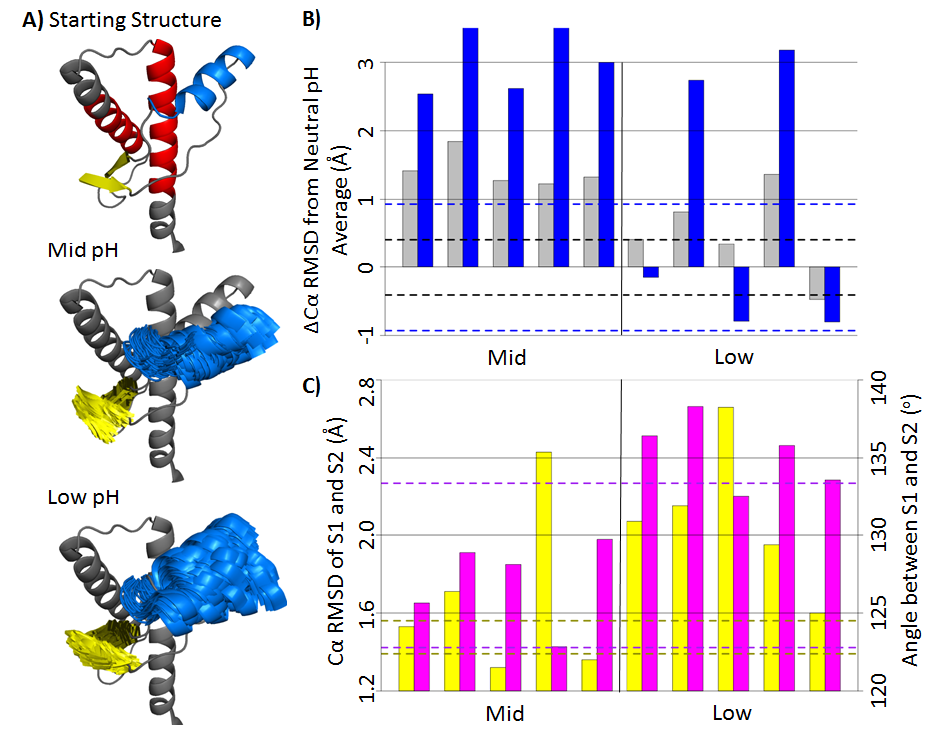
Figure 3. Conformational changes of bovine PrP at mid- and low pH. (A) Starting structure of the globular domain (residues 128–228) is shown in gray. HA (residues 144–156) and the native sheet (residues 128–131 and 161–164) are colored as blue and yellow, respectively. Top: the starting structure of the globular domain of the PrP. The stable core region (residues 174–186 and 200–219) is in red. Middle and Bottom: the starting structure of the globular domain overlapped with frames from 25–50 ns of mid- and low pH simulations for HA and the native sheet. The structures are aligned to the stable core region. (B) Cα RMSD difference (∆Cα RMSD) from the average value (last 25 ns) of the neutral pH simulations. The ∆Cα RMSD of the globular domain and HA are colored in gray and blue, respectively. The dotted lines indicate Cα RMSD standard deviations of the neutral pH simulations. (C) Average Cα RMSD of the native sheet (yellow) and inter-strand angle between S1 and S2 (magenta) for the last 25 ns in each simulation. The area within the yellow dotted lines indicates values within one standard deviation of the averaged Cα RMSD of the neutral pH simulations. Dotted lines in magenta indicate the extreme angles in neutral pH